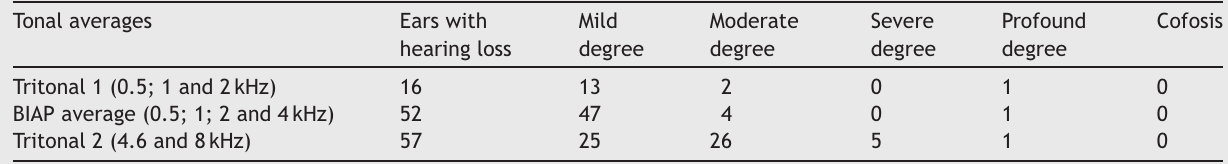
Mild Moderate Severe Profound Cofosis hearing loss degree degree degree degree